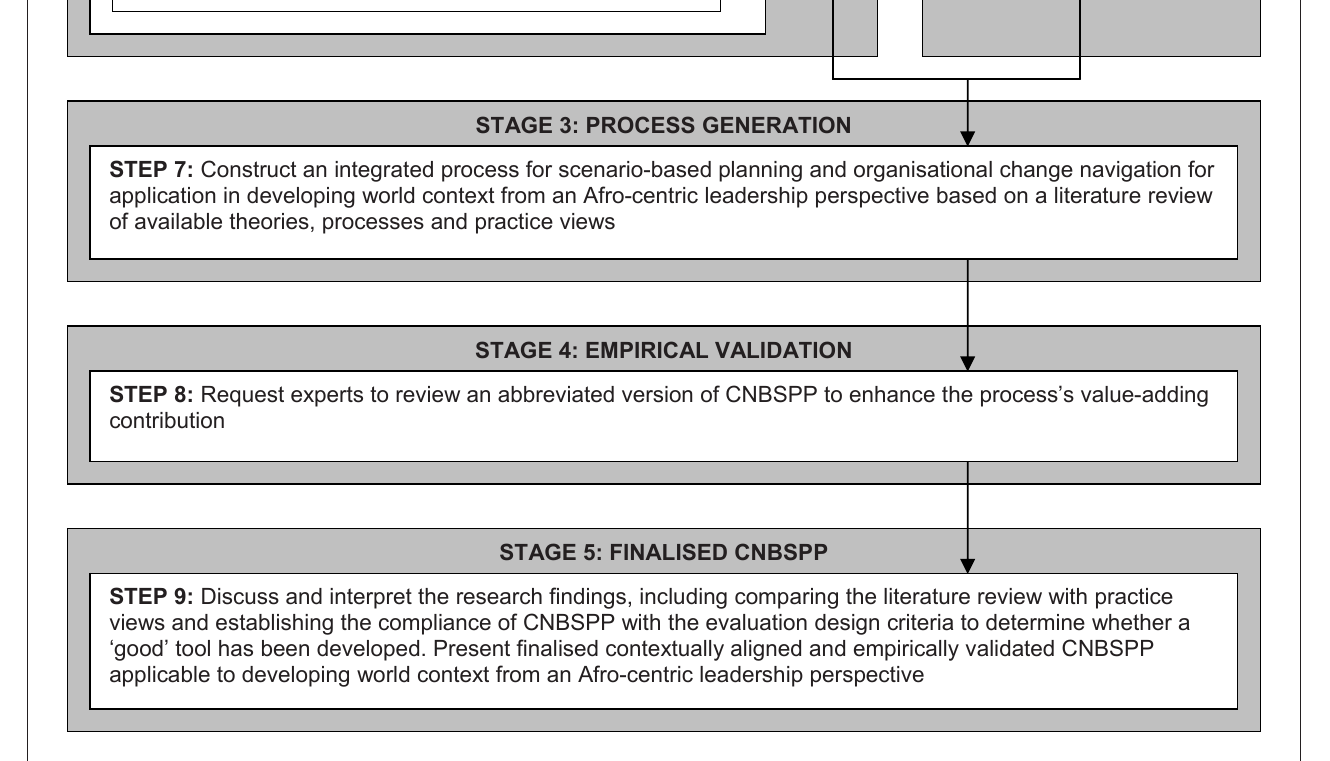
FIGURE 1: Schematic illustration of the five stage research process followed in this study.